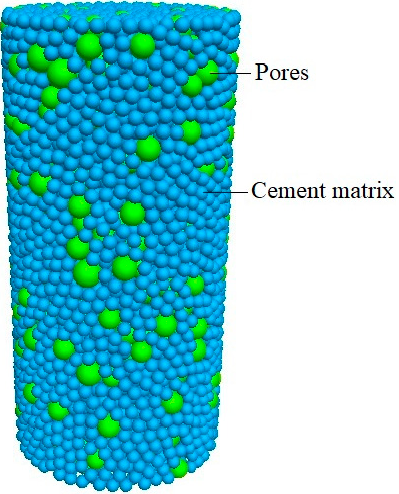
Figure 8. DEM model with a density of 750 kg/m 3